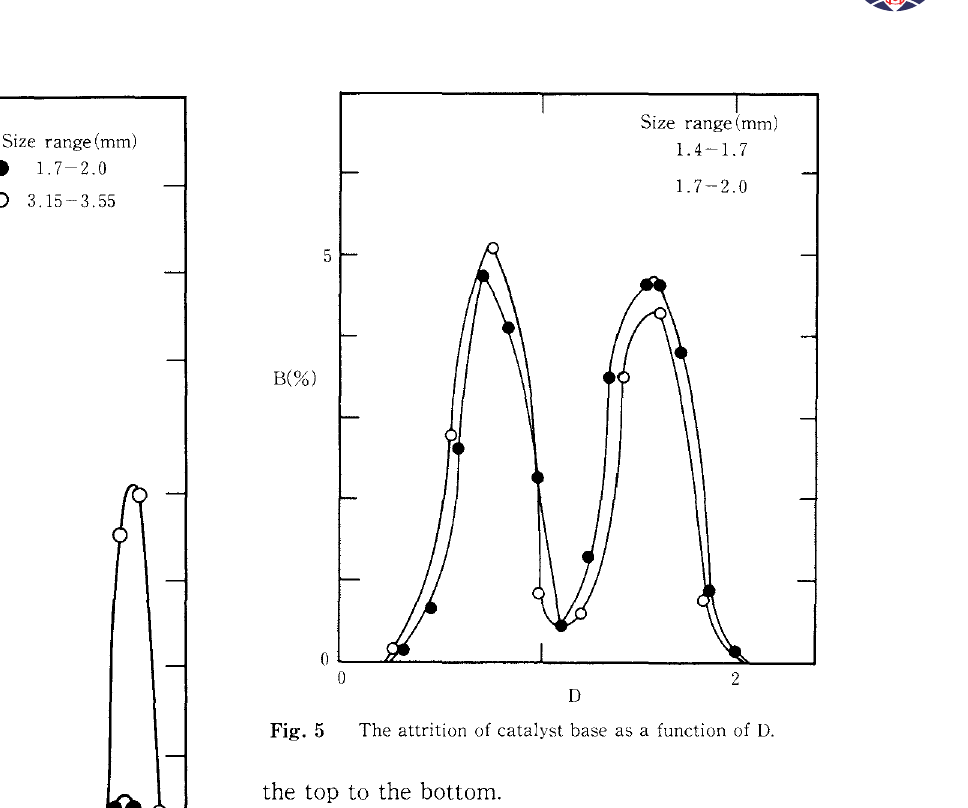
The attrition of catalyst base as a function of D. the top to the